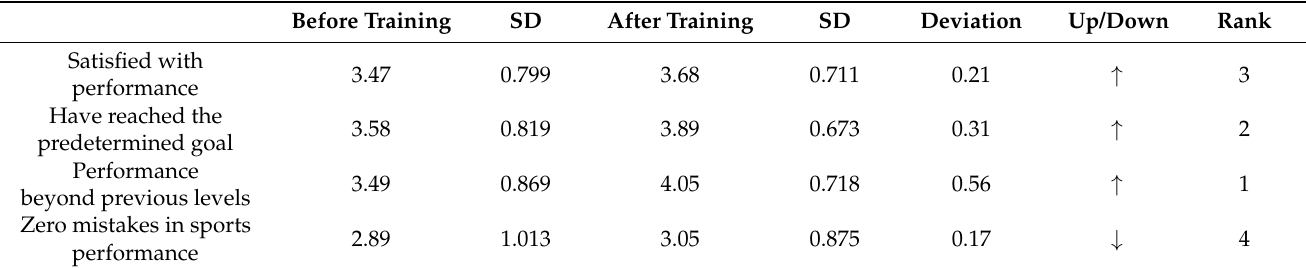
Table 6. Perception analysis of effects of imagery training on athletic